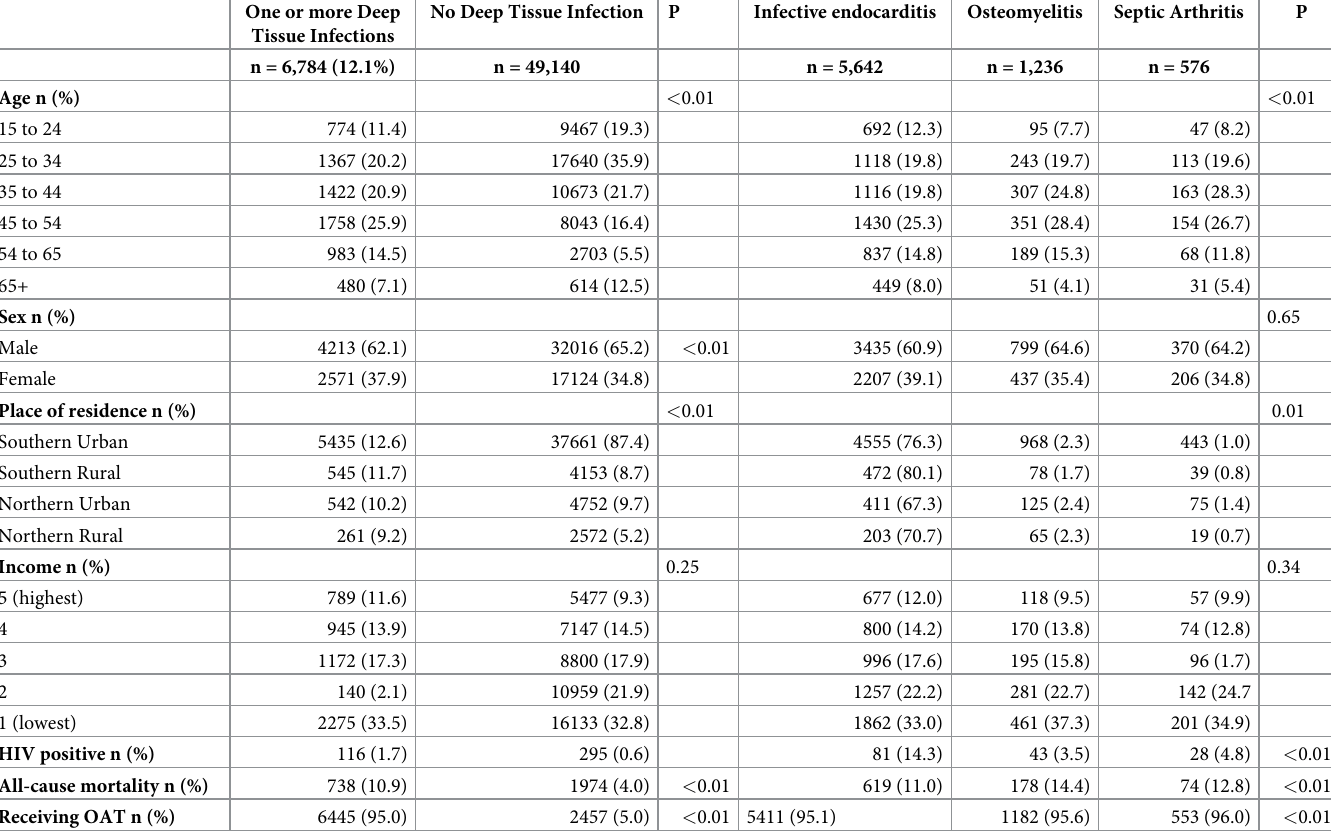
Table 2. Frequencies, descriptive statistics and Chi-square statistics of each patient characteristics